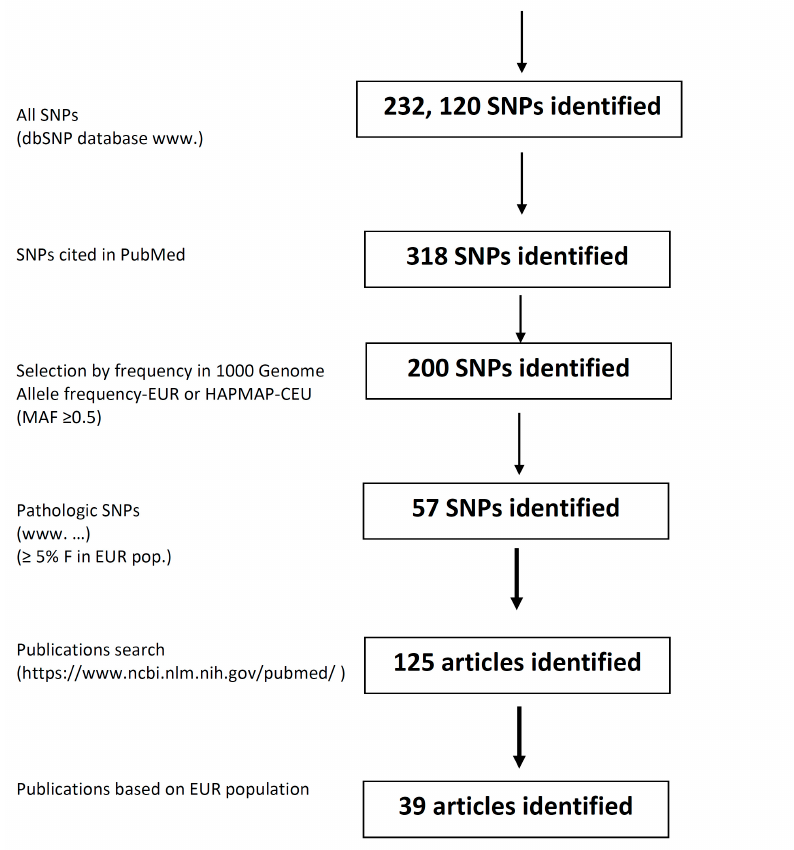
Figure 2. Workflow of the study.